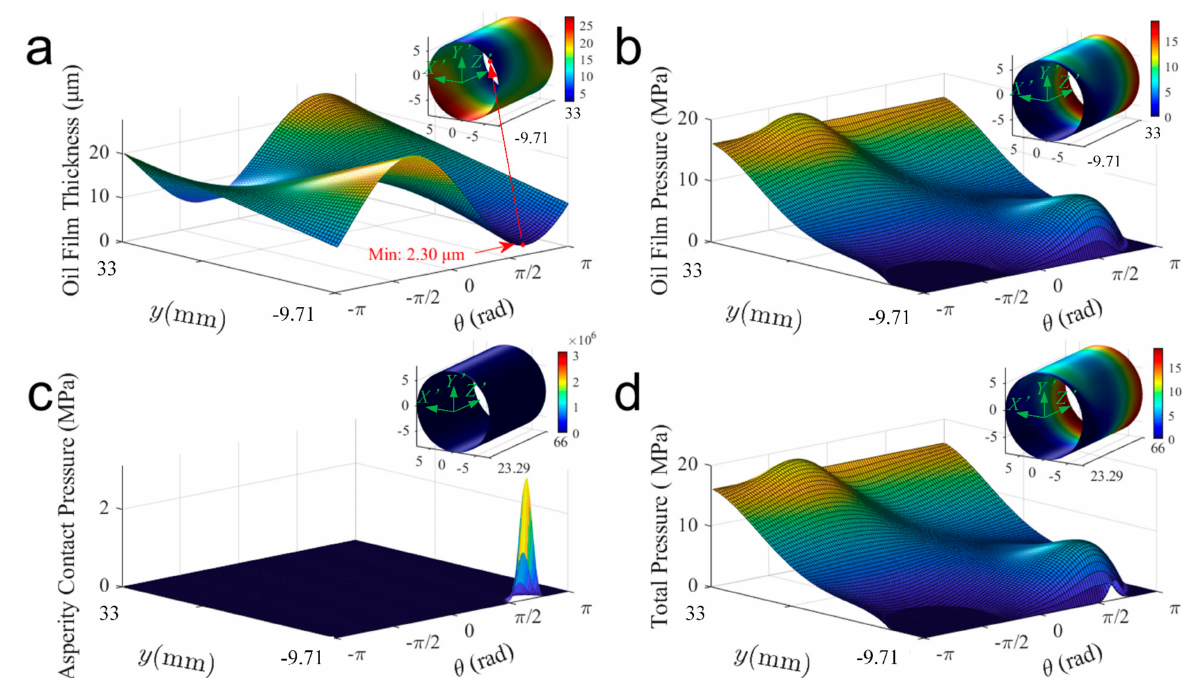
Figure 12. The oil film thickness and pressure distribution at about 37 ◦ SA: ( a ) the oil film thickness, ( b ) the oil film pressure, ( c ) the micro-asperity contact pressure, and ( d ) the total contact pressure.